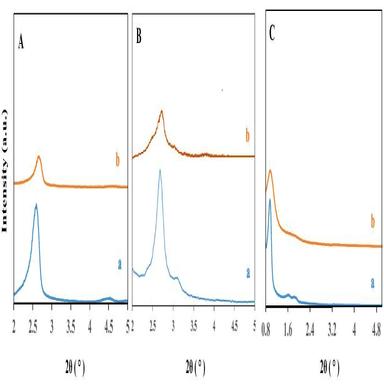
XRD pattern of a sulfonic acid functionalized mesoporous materials, b Zn complex incorporated ordered mesoporous materials. (A) MCM-41, (B) MCM-48, (C) SBA-15.